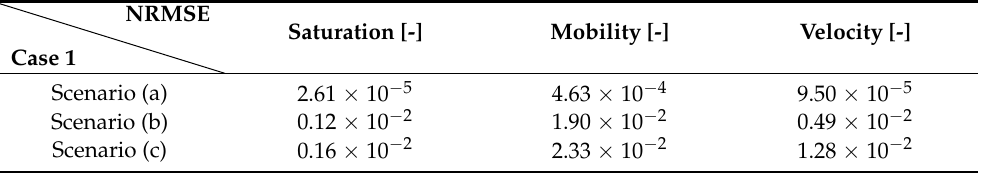
Table 7. NRMSE values for the mobile (liquid) phase parameters between the Darcy and Forchheimer– Case 1 models (t =